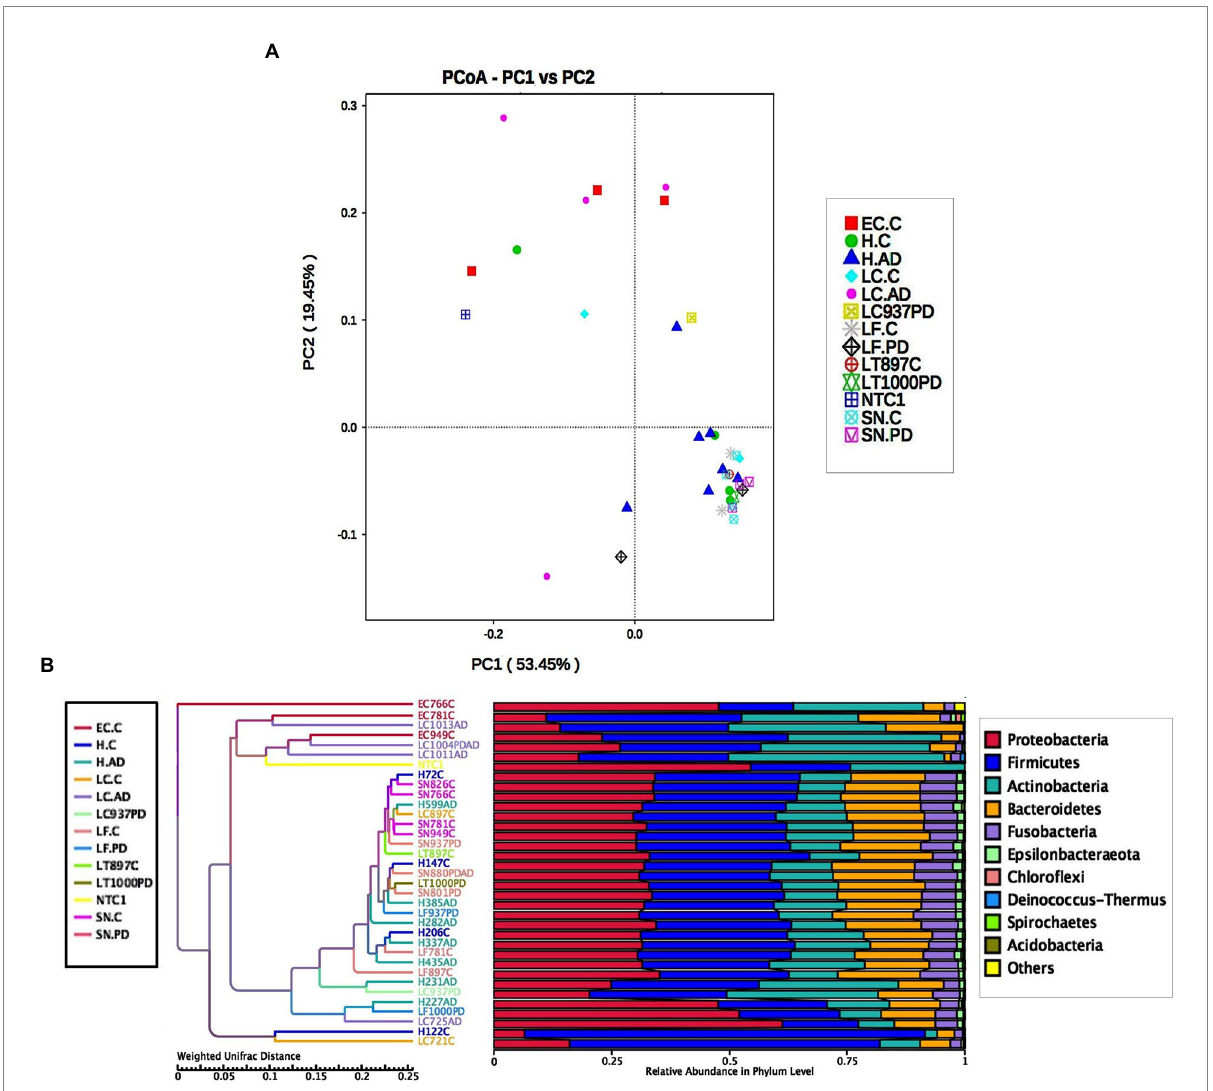
population profile to the other brain samples. Supplementary Table S10A shows the top 20 genera from each brain group, alongside that of blood, and indicates that 45–65% of genera were common to both blood and brain groups. The relative abundance of these, however, differed considerably between brain and blood (Figure 3). For instance, the low oral content brain groups contained around half the Streptocococcus levels seen in blood (5.1% in EC-C and 6.3% in LC-AD compared to 10.6% in blood) and considerably less Haemophilus (1.5% in EC-C and 3.2% in LC-AD compared to 8.5% in blood). In contrast, high oral brain groups averaged 22.3% Streptococcus and 20.1% Haemophilus . Three blood genera, Acidovorax (10.4%), Tepidomonas (1.2%) and Sphingomonas (0.9%) were not present in brain